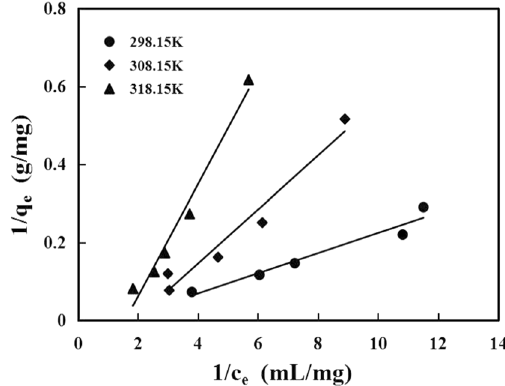
Fig. 3 Langmuir adsorption isotherm